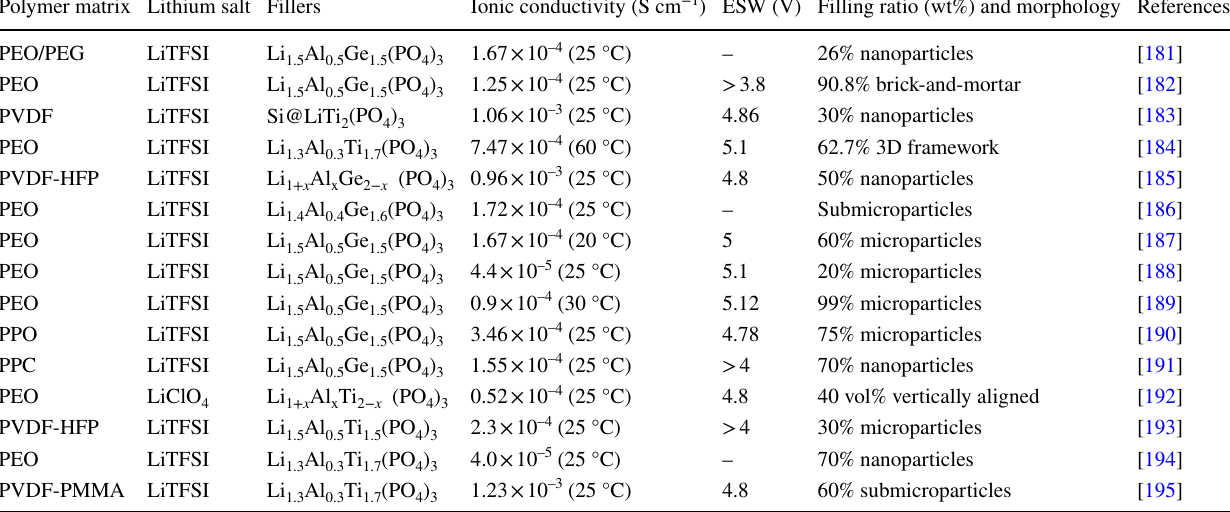
Table 4 PIEs filled with NASICON-type fillers and their properties Polymer matrix Lithium salt